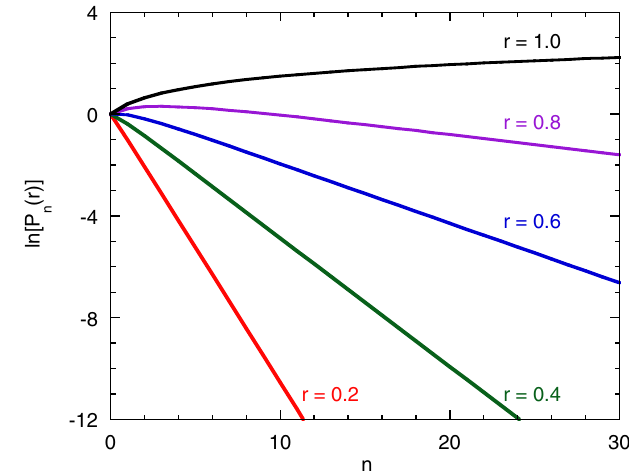
(cid:3) r (cid:4) as a function of n for various n